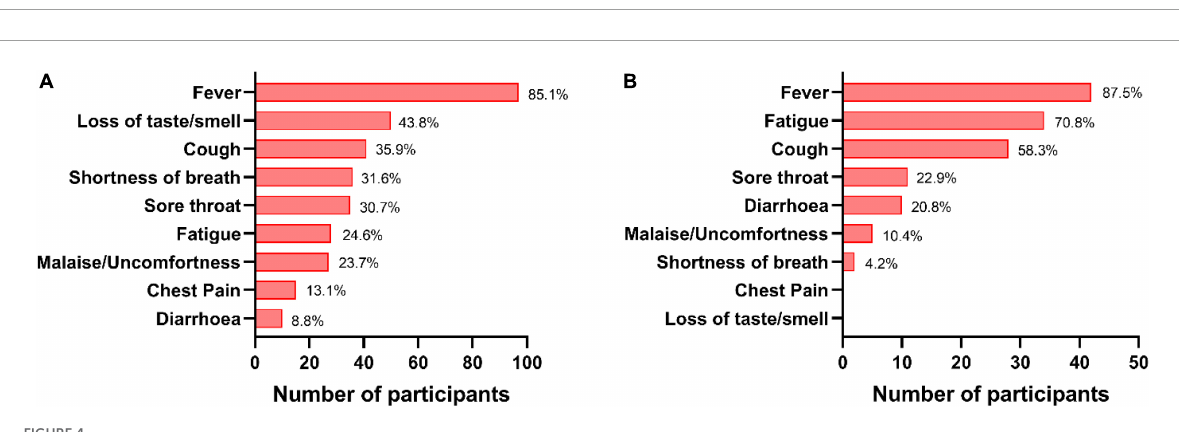
Among the 146 booster recipients, 94 had no history of vaccine breakthrough and were analyzed separately. The recipients, the median titer of anti-S RBD IgG hiked from 229.9 AU/ml (IQR: 16.3–3,260.5) to 8,661.0 AU/ml (IQR: 2,335.1–22,698.8) at BD1. The inhibitory percentage of neutralizing antibodies was recorded at 90.95% and